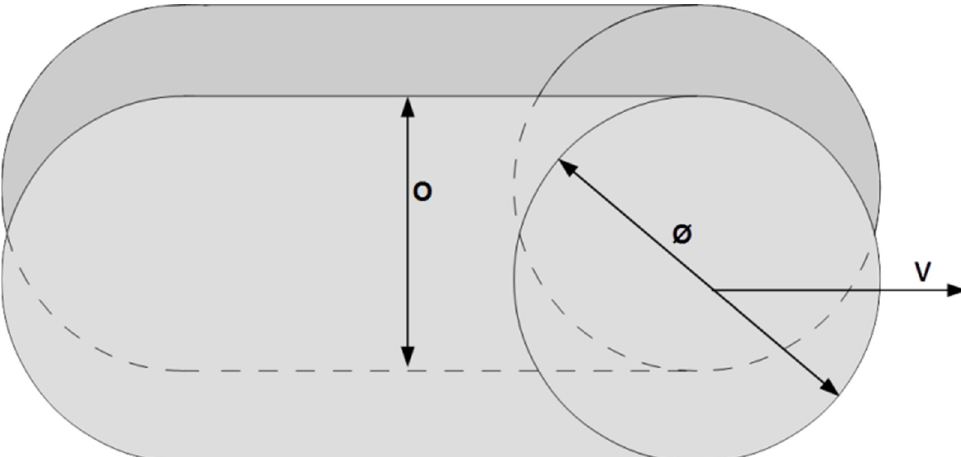
Figure 1. Schematic illustration of the DoE parameters studied. Ø is the laser spot diameter; ν the velocity of the displacement; O is the % overlap between two successive lines. The last parameter is the maximum temperature T , related to the laser power of the source.